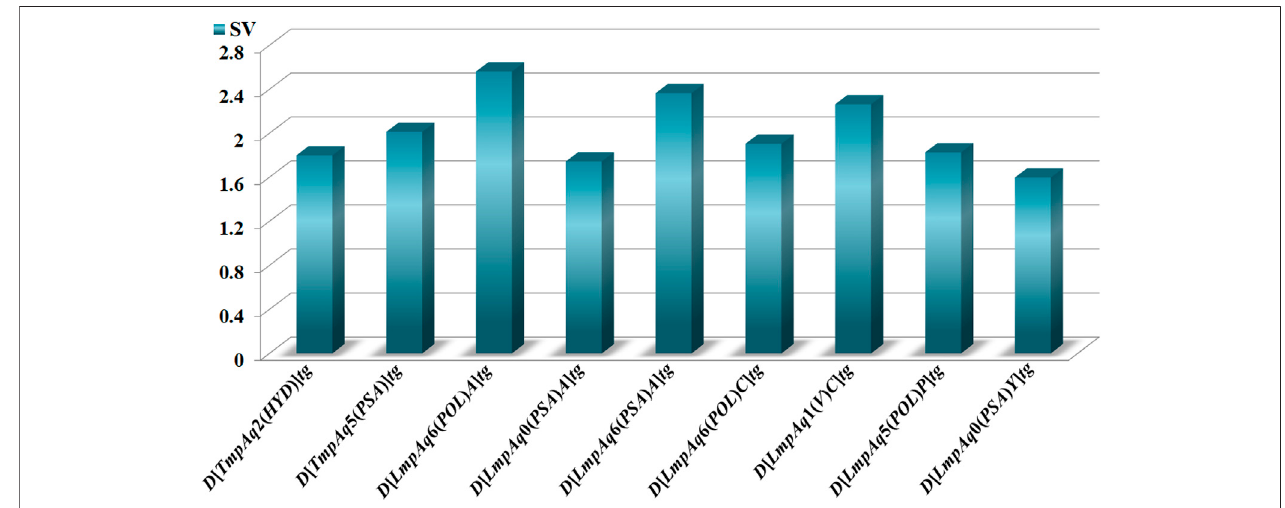
FIGURE 2 | Molecular descriptors and their statistical in fl uences in the mt-QSAR-MLP model.